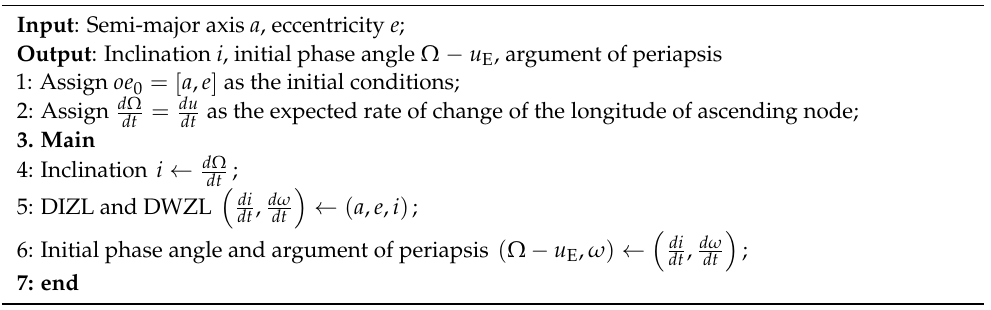
Algorithm 1 Design Method for a Ganymede-Synchronous Frozen